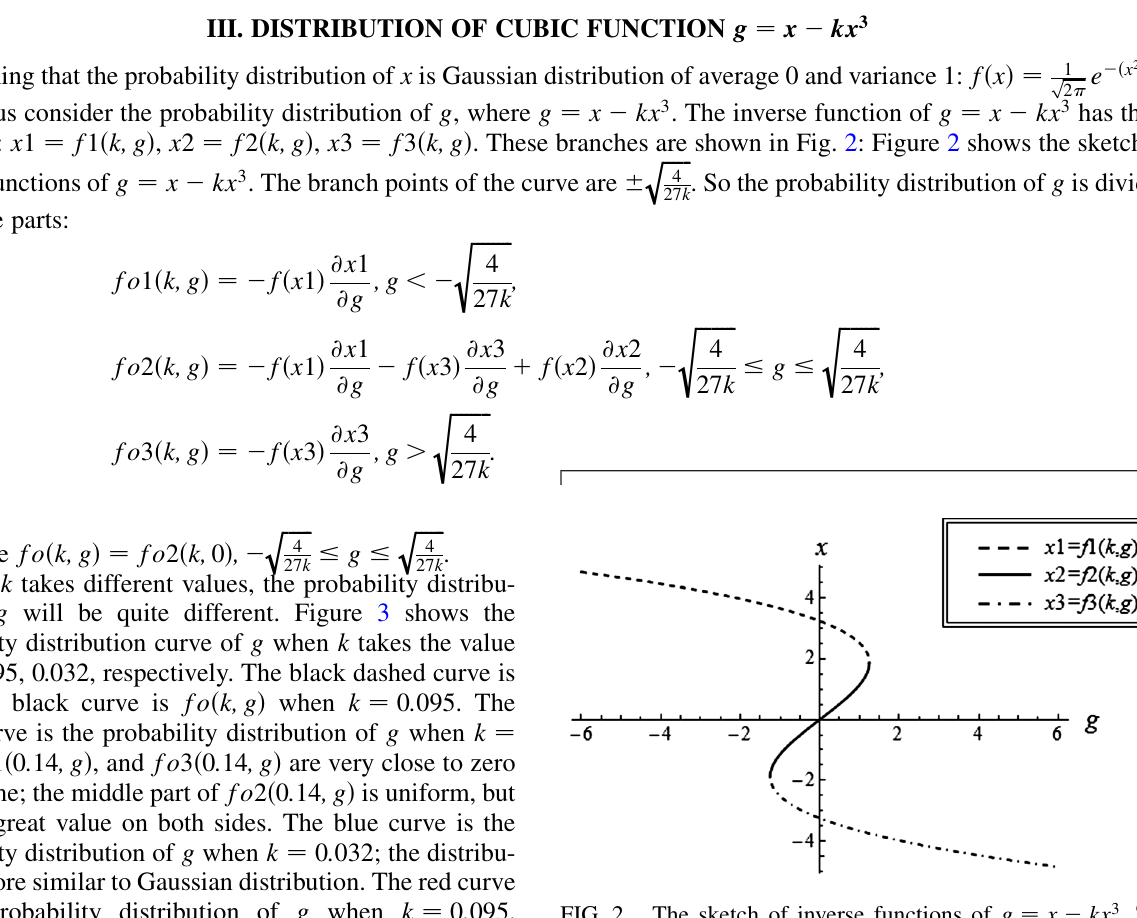
ffiffiffiffiffiffi q 4 27 k